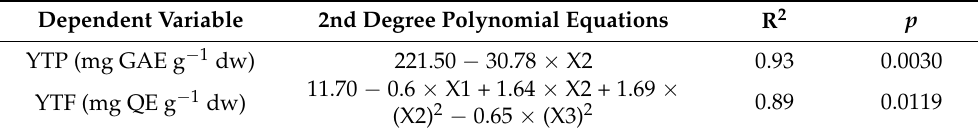
Table 3. Polynomial equations and statistical parameters calculated by applying a central composite